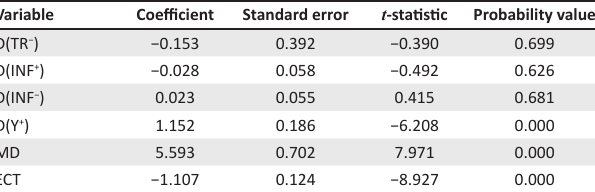
TABLE 4: Error correction model